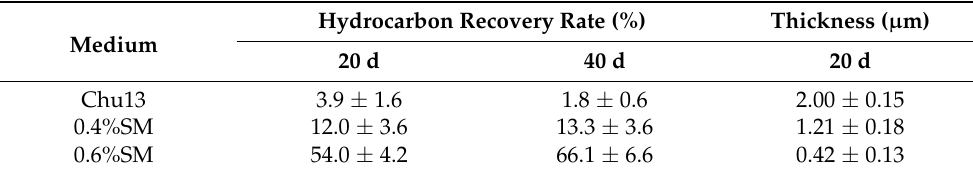
Table 2. Hydrocarbon recovery rate and thickness of colony sheath of B. braunii Yamanaka strain cultured in three different media.